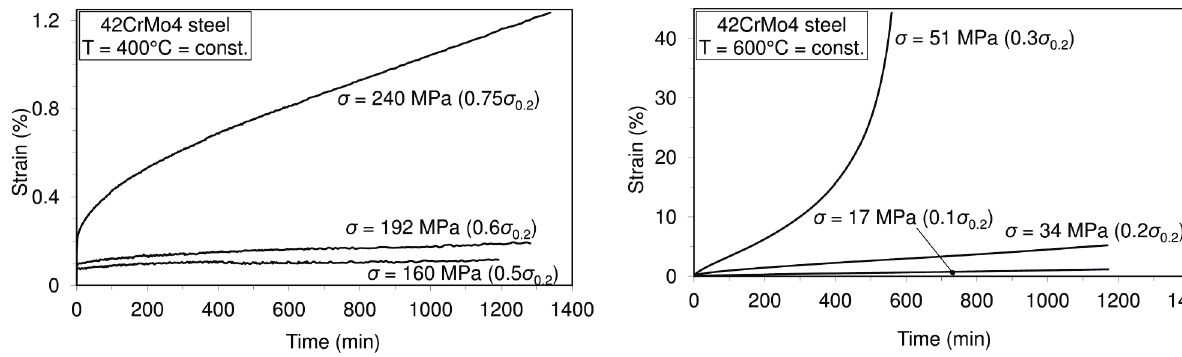
Fig. 6: Short-time creep tests of 42CrMo4 steel at a temperature of 600 °C (873